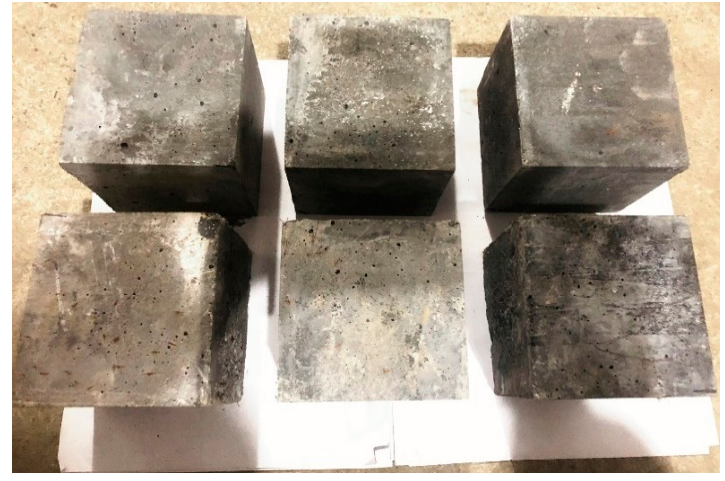
Figure 7. Cubic specimens.